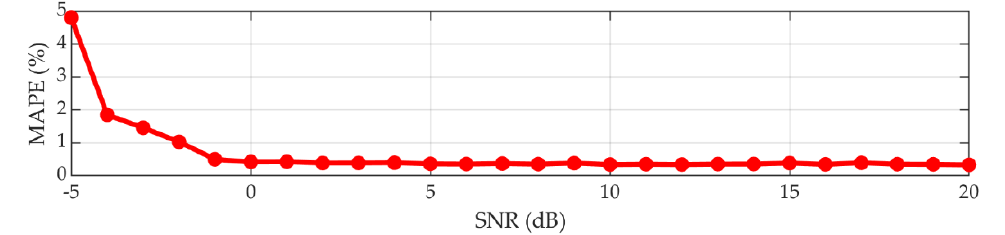
Figure 3. The MAPEs with varying levels of SNR.